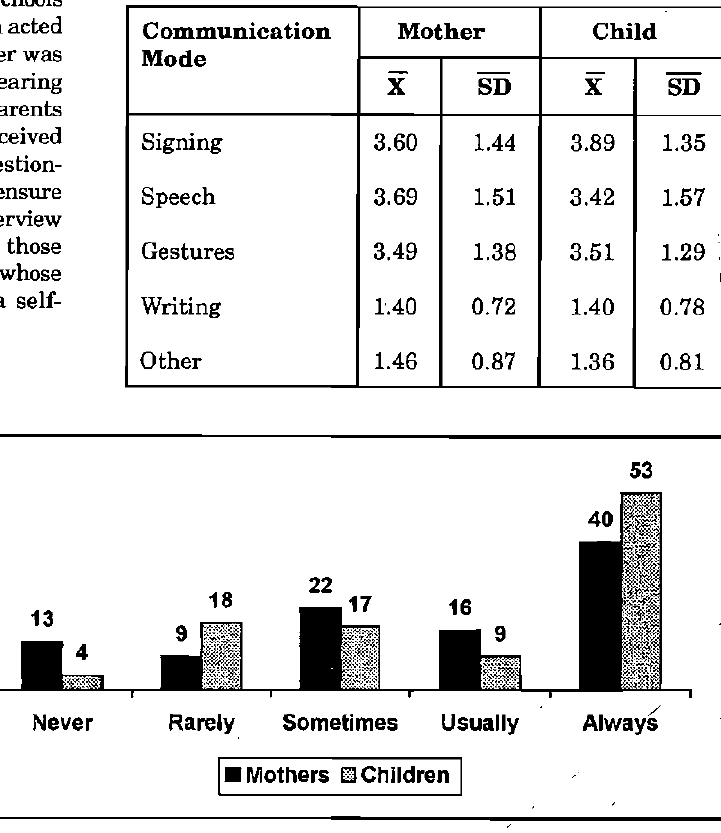
FIGURE 1: Comparison of mothers' and children's use of